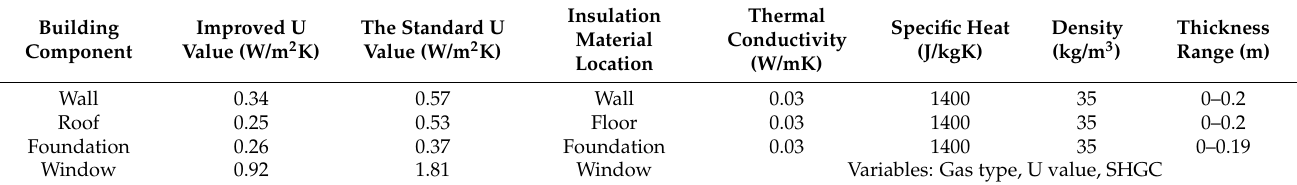
Table 3. Heat transfer coefficients and thickness range of thermal insulation material in the